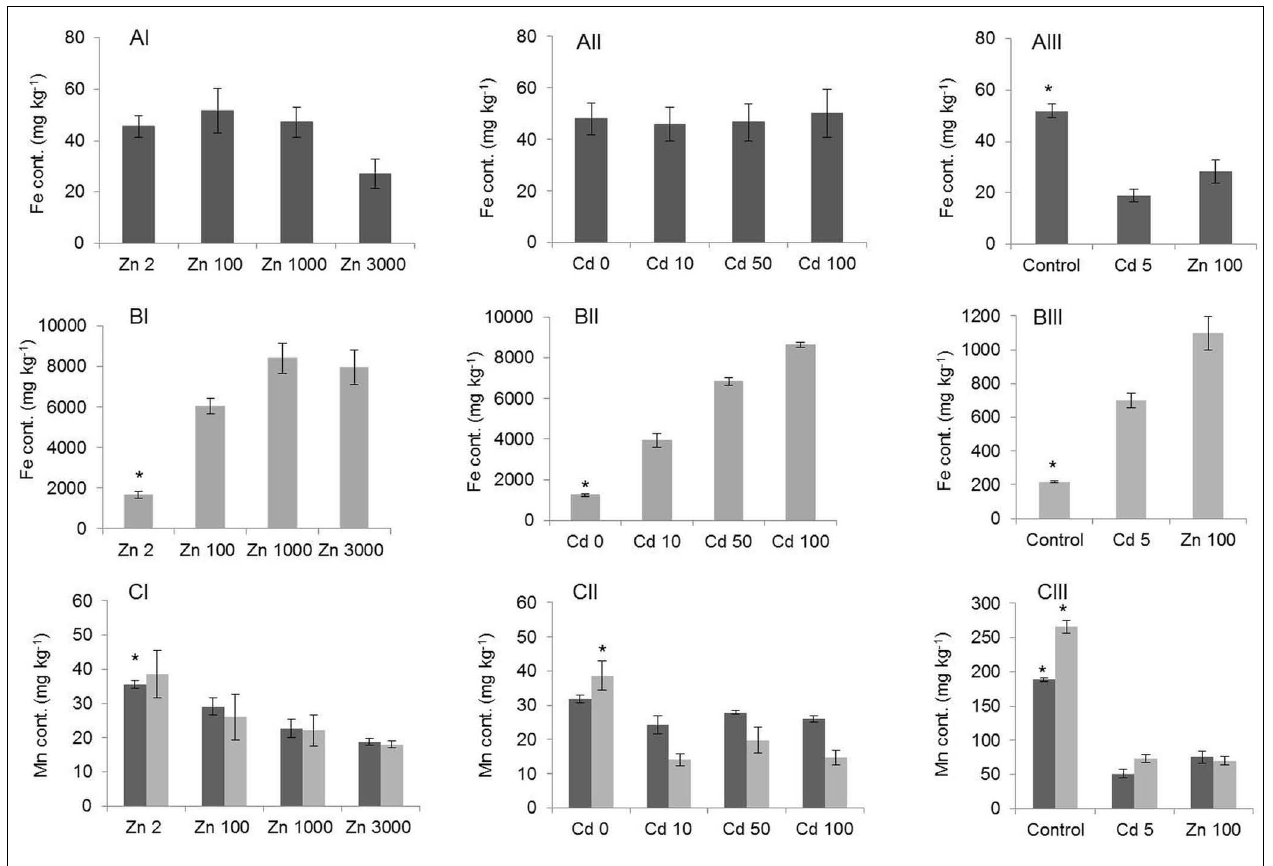
FIGURE 7 | Iron (Fe) (A,B) and manganese (Mn) (C) concentrations (mg kg –1 ; mean ± SE) in G. claussenii (I,II) and G. elegans (III) shoot (dark gray bars) and root (light gray bars). Plants were grown for 3 weeks on control solution (Zn 2 μ M) before exposure to Zn (2, 100, 1000, and